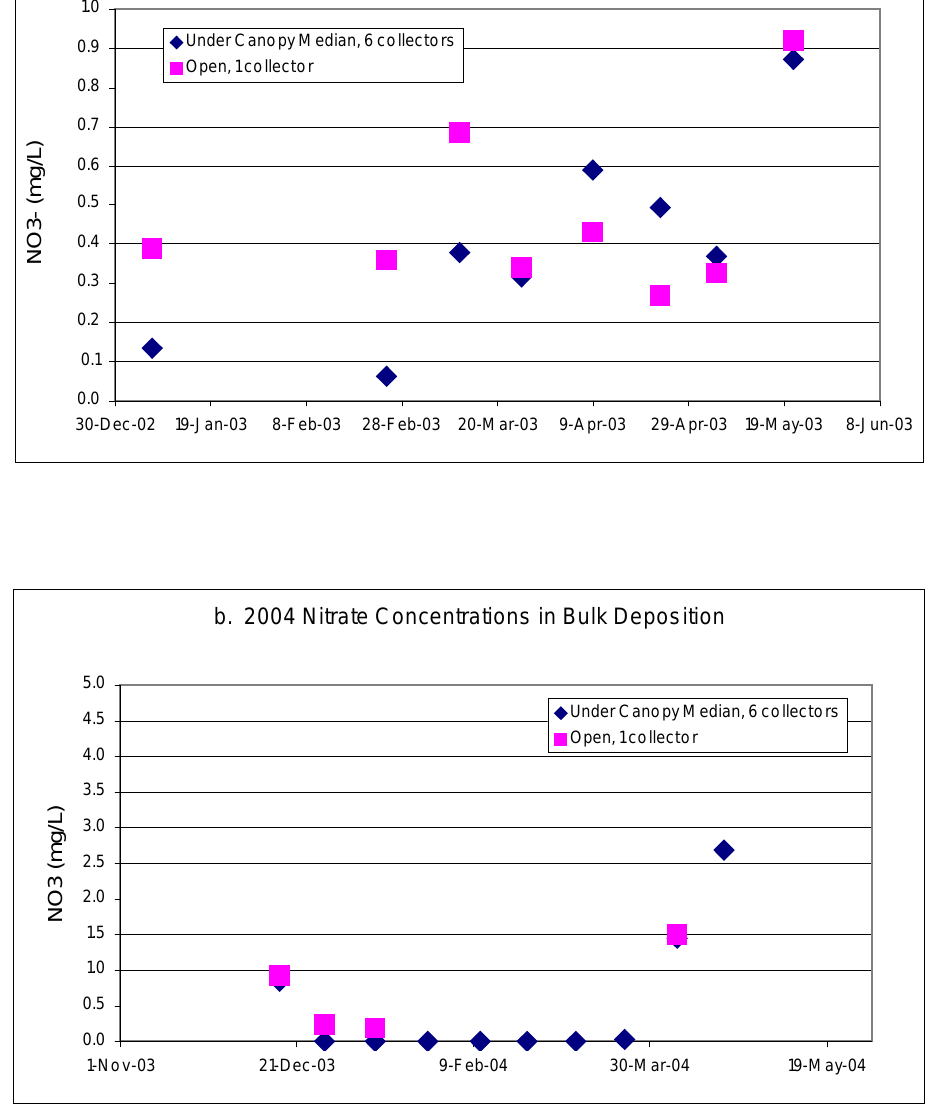
FIGURE 3 . Bulk deposition (snowmelt) samplers, open and throughfall, at watershed 303 in the Providence Site. Values reported are medians. (a) 2003 nitrate concentrations; (b) 2004 nitrate concentrations; (c) 2003 ammonium concentrations; (d) 2004 ammonium